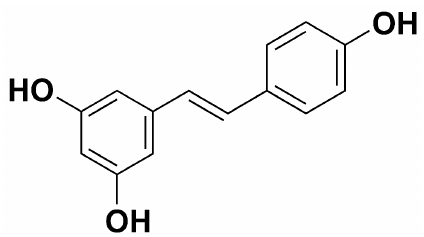
Figure 1. Chemical structure of trans -resveratrol.